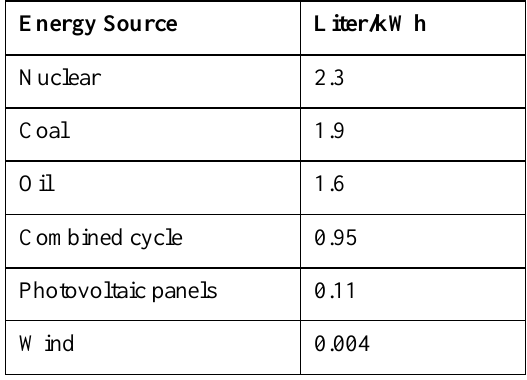
Table 1. Liters of water used per kWh of electricity generation from different energy sources